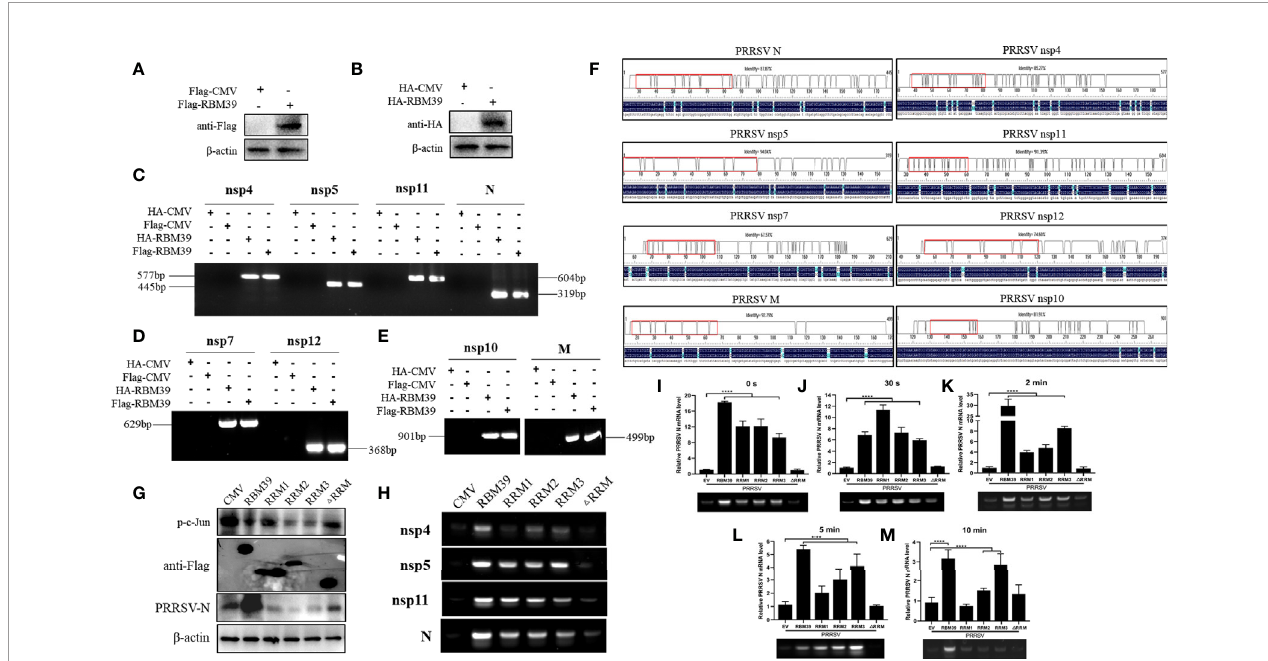
FIGURE 8 | RBM39 binds to PRRSV RNA. (A, B) 3D4/21 cells were transfected with Flag/HA-RBM39 and infected with PRRSV 12 h after transfection. After another 24 hours, the cells were detected for immunoblotting analysis with anti HA/Flag mAb. (C – E) The agarose gel electrophoresis of PRRSV nsp4, nsp5, nsp7, nsp10-12, M and N PCR products after extracted RNA was reverse transcribed and ampli fi ed with corresponding primers. (F) Comparison of sequencing results using DNAMAN. (G – M) 3D4/21 cells were transfected with Flag-RBM39, RRM1, RRM2, RRM3, D RRM, or empty vector respectively and infected with PRRSV 12 h after transfection. After another 24 hours, the cells were tested for immunoblotting (G) and RIP analysis. (I – M) The PRRSV N level was analyzed by qRT-PCR after RIP. (H) The agarose gel electrophoresis of PRRSV nsp4, nsp5, nsp11, and N PCR products. Data are representative of results from three independent experiments. The statistically signi fi cant at P-value was demonstrated in Statistical Analysis .